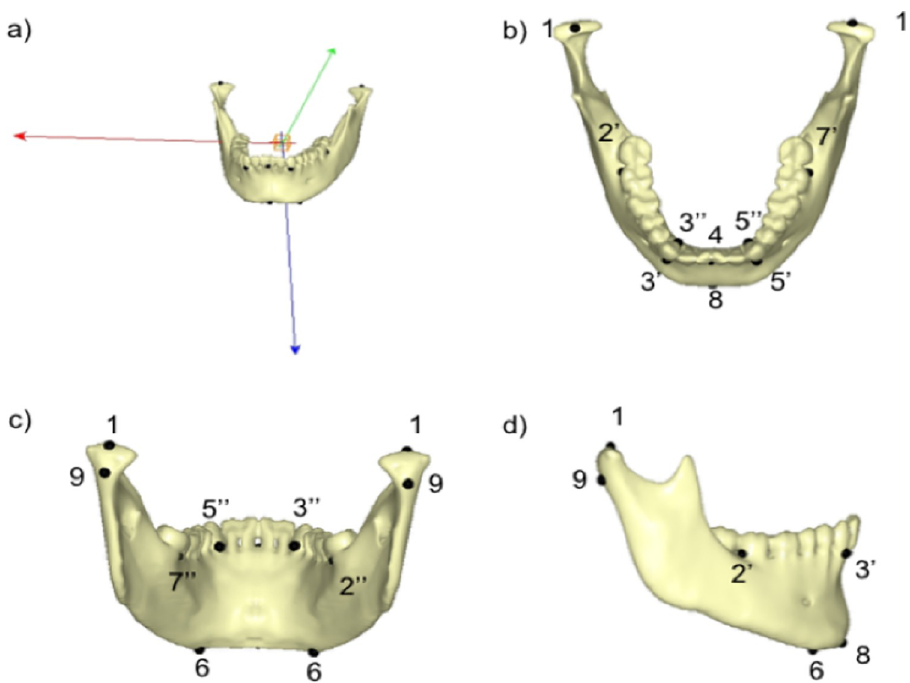
Fig 1. Selected landmarks on the mandible STL file surface. a: 3D visualization of an STL file of the mandible in an orthonormal reference frame (Viewbox software). b-c-d: LMs are positioned on the surface and are identified by their Cartesian coordinates. 1: Upper condyle. Upper reference point of the condyle.2: Molar 47. Middle of segment 2’ (vestibular aspect of the distal surface of 47)-2’’(lingual aspect of the distal surface of 47).3: Canine 43. Middle of segment 3’ (middle of the vestibular cementoenamel junction (CEJ) of tooth 43)-3’’(middle of the lingual CEJ of tooth 43). 4: Inter-incisor reference point. Reference point located in the middle of the CEJ of teeth 31 and 41. 5: Canine 33. Middle of segment 5’ (middle of the vestibular cementoenamel junction (CEJ)of tooth 33) - 5’’ (middle of the lingual CEJ of tooth 33) (see below). 6: Basilar projection of the mental foramen. 7: Molar 37. Middle of segment 7’ (vestibular aspect of the distal surface of 37) - 7’’ (lingual aspect of the distal surface of 37). 8: Mental protuberance reference point. The lowest reference point and symphysis median. 9: Posterior condyle reference point. Most posterior lying condyle reference